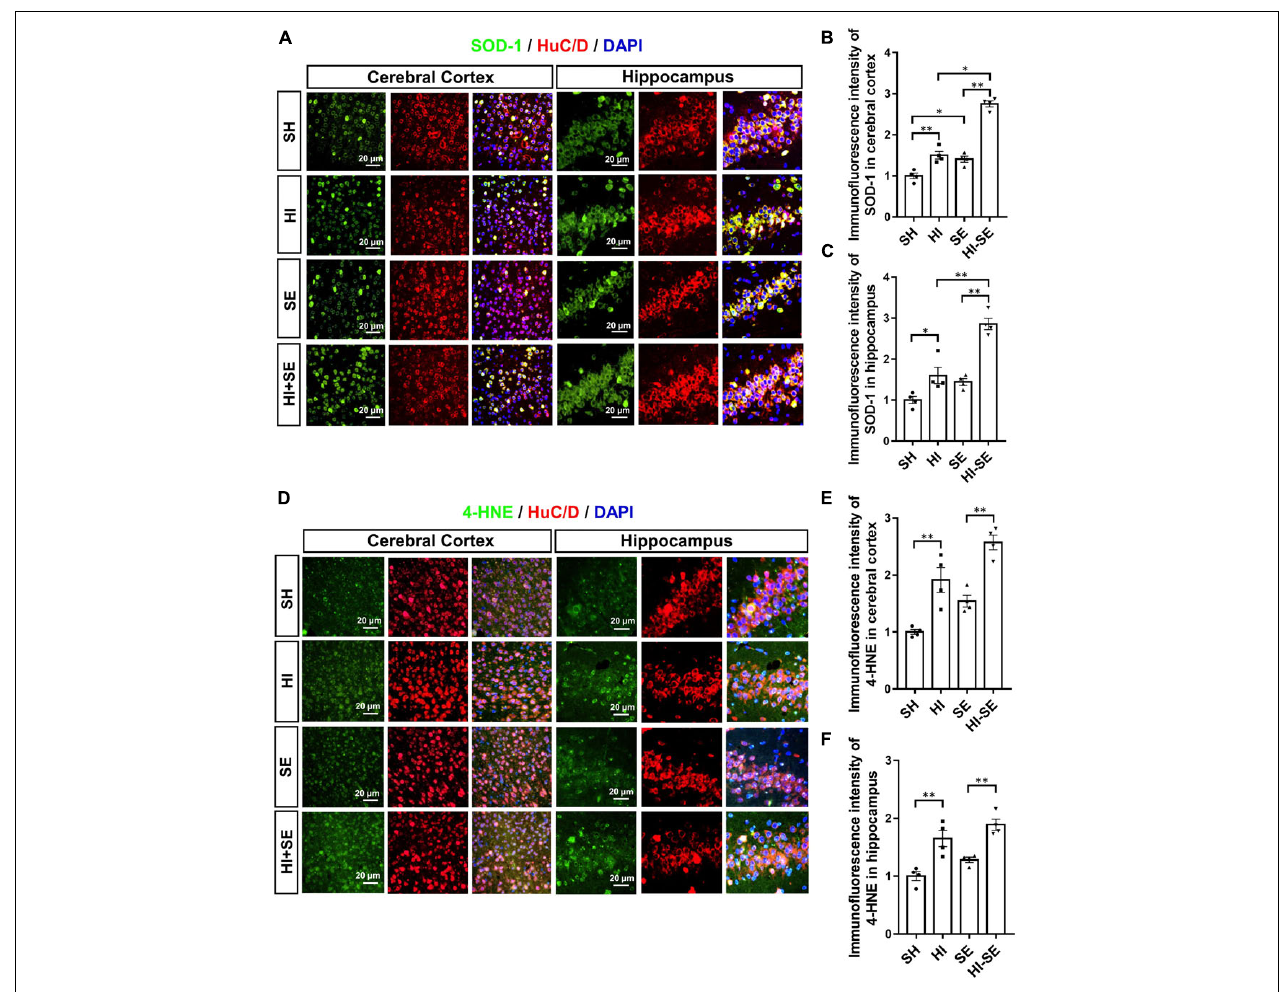
FIGURE 6 | Maternal SE enhanced oxidative stress caused by HI injury. Representative images of SOD-1 and HuC/D immunofluorescence staining in the cerebral cortex and the hippocampus (A) . The immunofluorescence intensity of SOD-1 in the cerebral cortex (B) and hippocampus (C) . Representative images of 4-HNE and HuC/D immunofluorescence staining in the cerebral cortex and the hippocampus (D) . The immunofluorescence intensity of 4-HNE in the cerebral cortex (E) and the hippocampus (F) . Results are presented as mean ± SEM. ∗ P < 0.05, ∗∗ P < 0.01, n = 4, analyzed by two-way ANOVA followed by post hoc Turkey tests. SH, from sham exposed dams with sham surgery; HI, hypoxic-ischemic injury; SE, from smoke exposed dams with sham surgery; HI + SE, from smoke exposed dams with hypoxic-ischemic